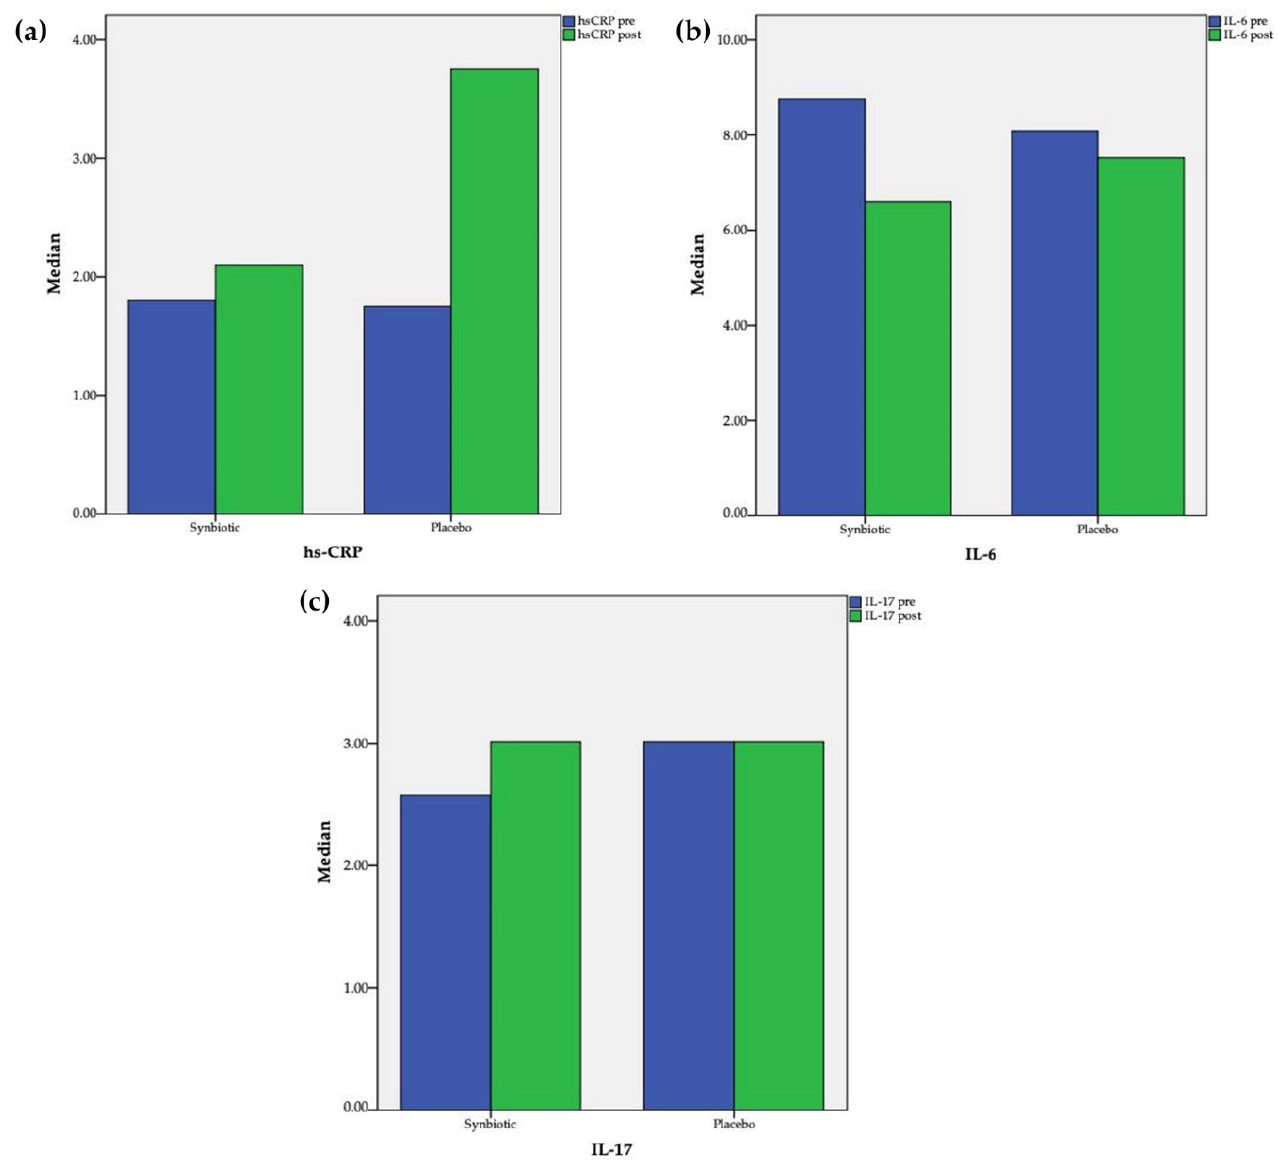
Figure 2. Changes after intervention in the synbiotic and placebo groups: ( a ) hs-CR; ( b ) IL-6; ( c ) IL- 17.